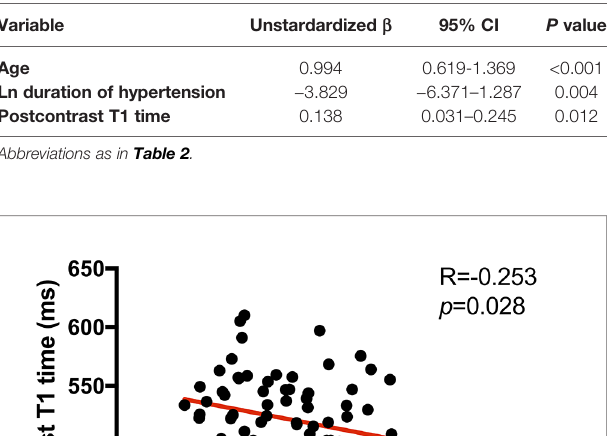
TABLE 4 | Independent determinants of LV global PDSR in PA patients.